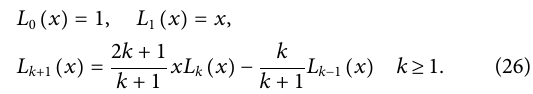
key steps of the PCE method according to Eq. 23: constructing the multi-dimensional Legendre orthogonal polynomial S Φ i ( x ) and solving the coef fi cient α i of the expansion. The common recurrence relation of the Legendre polynomial